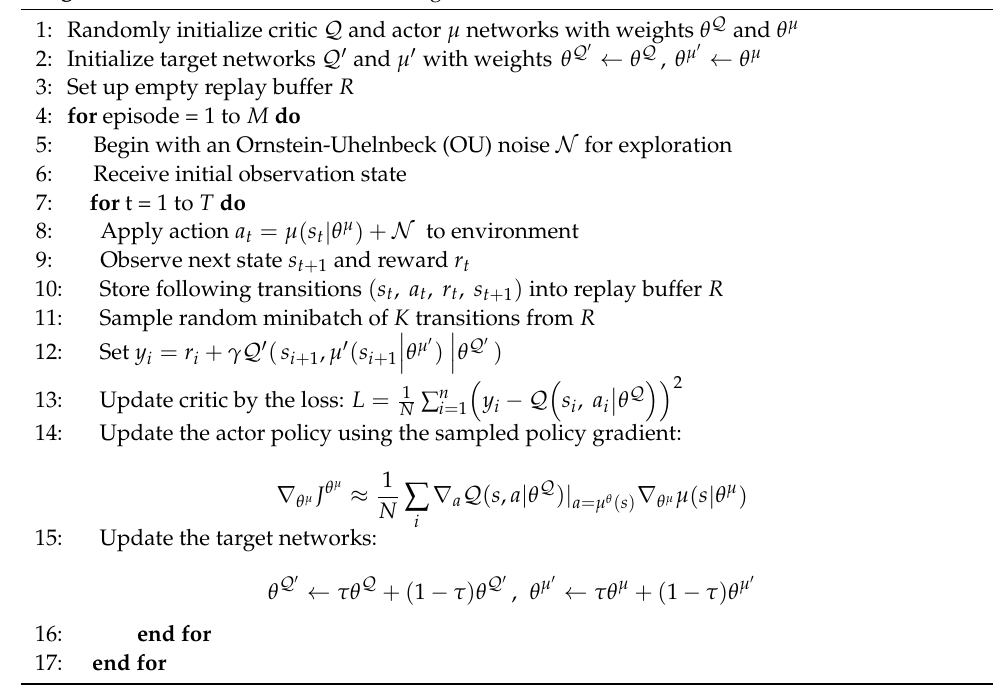
Algorithm 1: Procedure of the DDPG algorithm.